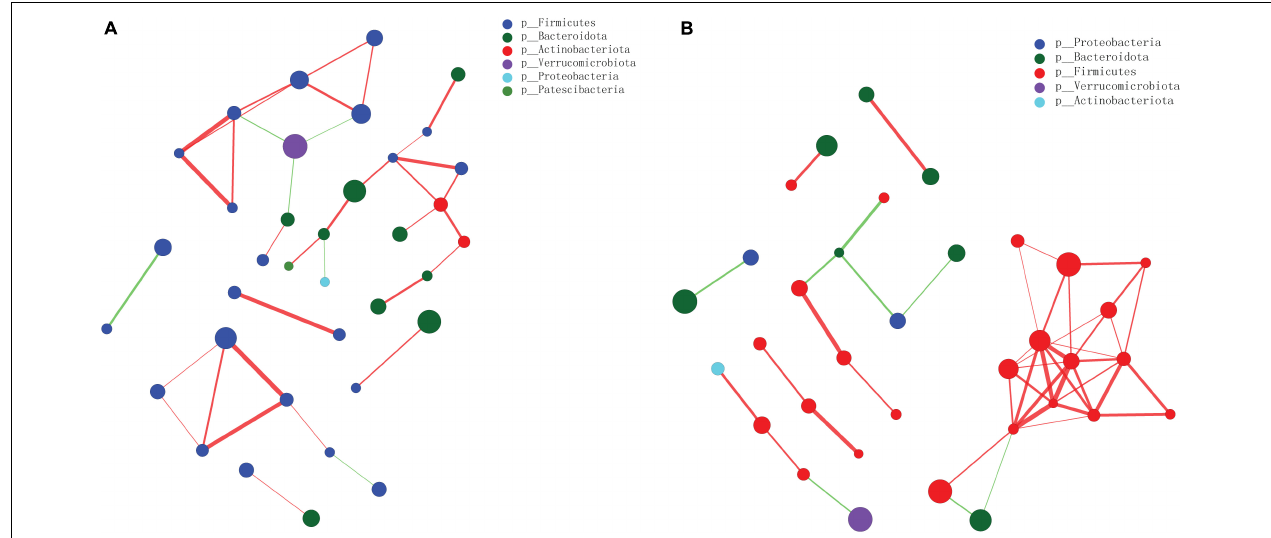
FIGURE 10 | The gut microbiota species correlation network analysis at the phylum level in the (A) AP vs. Sham and the (B) SB-500 vs. AP groups. The size of nodes indicates the abundance of gut microbiota species; the thickness of the line indicates the value of correlation coefficient; the color of the line indicates the positive correlation, the red and green indicate the positive and negative correlation between gut microbiota species, respectively. SB-500, 500 mg/kg butyric acid intervention group; AP, acute pancreatitis